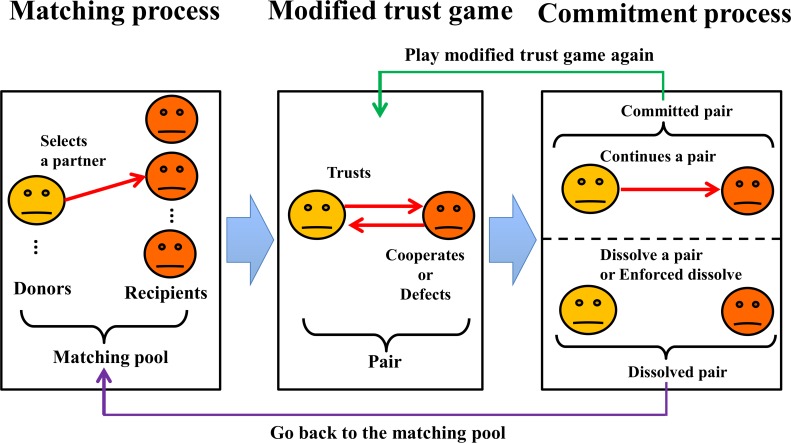
Procedure of the agent-based simulation.